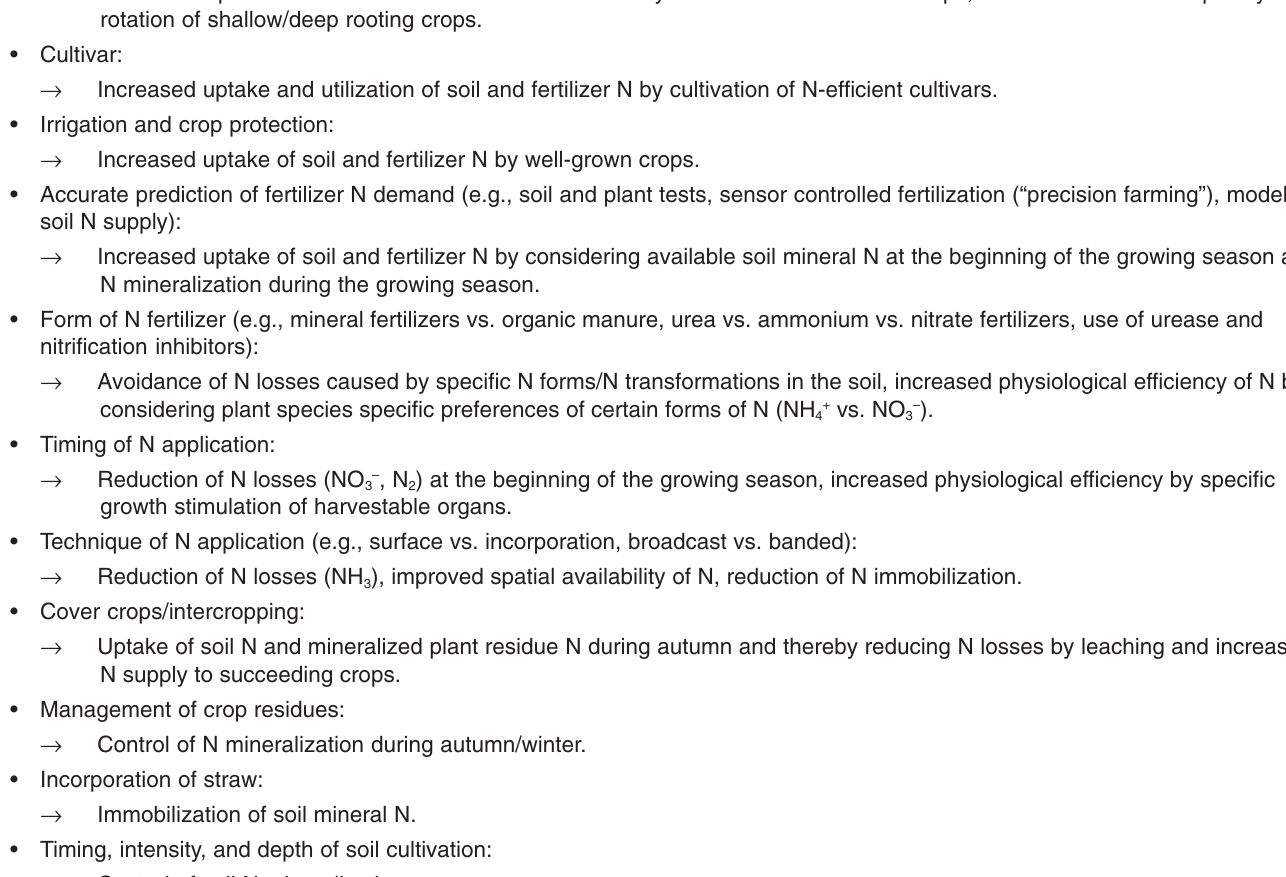
Elements of Integrated Nutrient Management Strategies that May Result in Improved N Efficiency in Plant